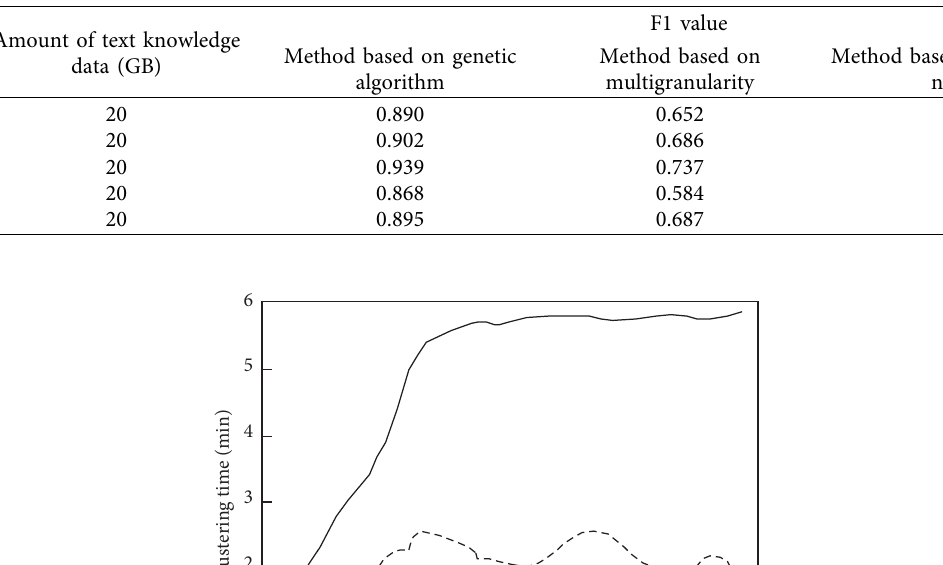
Table 2: Comparison results of clustering